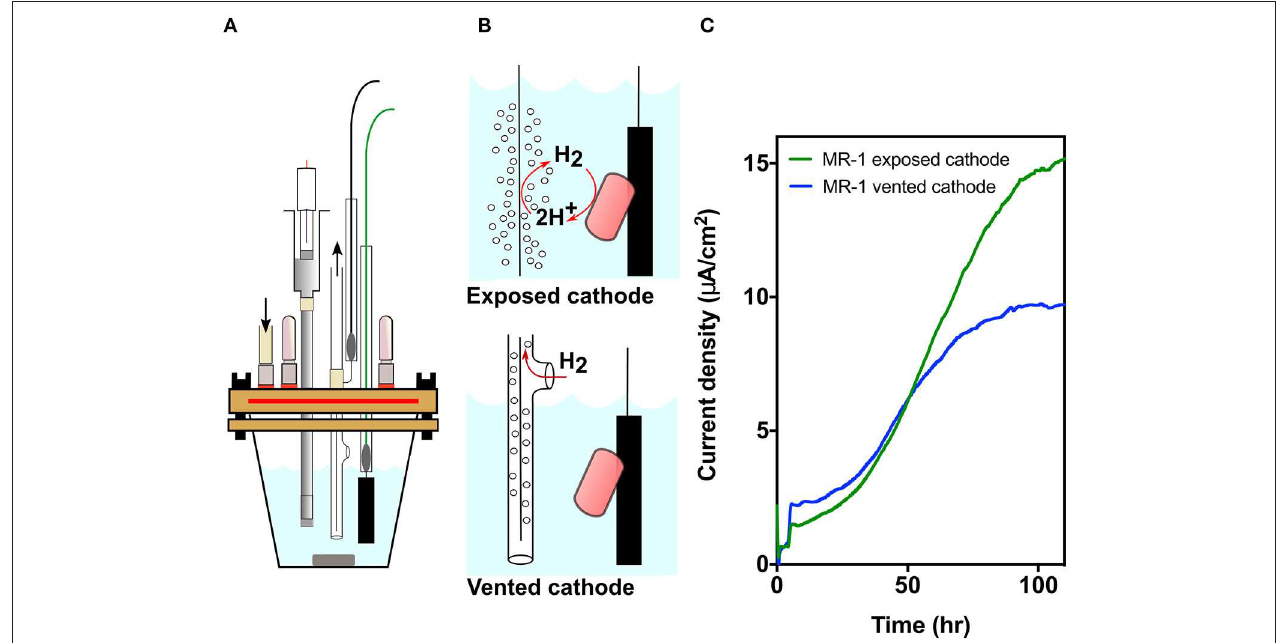
FIGURE 1 | MR-1 produces lower current density when cathodic hydrogen is vented. (A) Model of the new strictly anaerobic three electrode electrochemical cell. (B) Designs for exposed vs. vented cathodes to control release of cathodic hydrogen into the reactor. Hydrogen from the exposed cathode could suppress hydrogen disposal by bacteria, or serve as an electron donor if concentrations are high enough. (C) Current density over time for MR-1 cultures in new bioreactors containing exposed (green) and vented (blue) cathodes anodes poised at + 0.240V vs. SHE. Representative data from three independent experiments ( n = 3) are